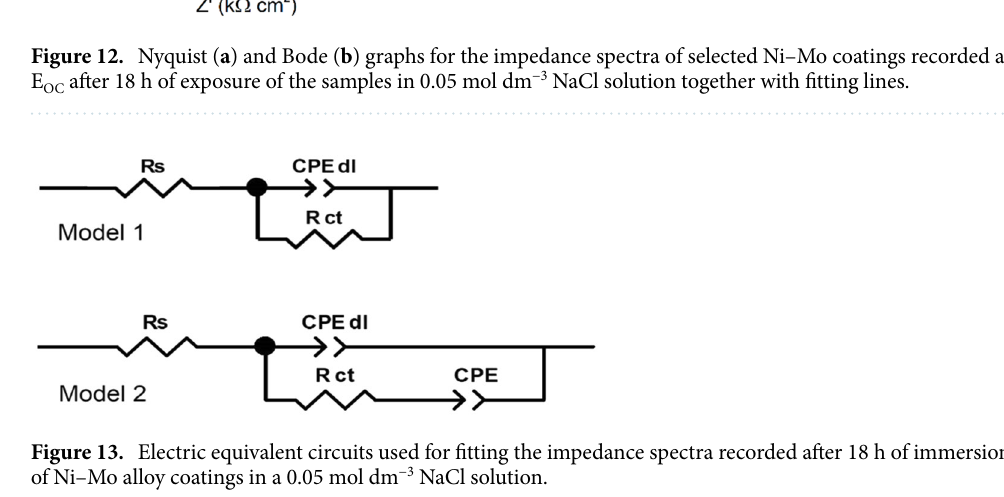
Deposition potential (V vs.